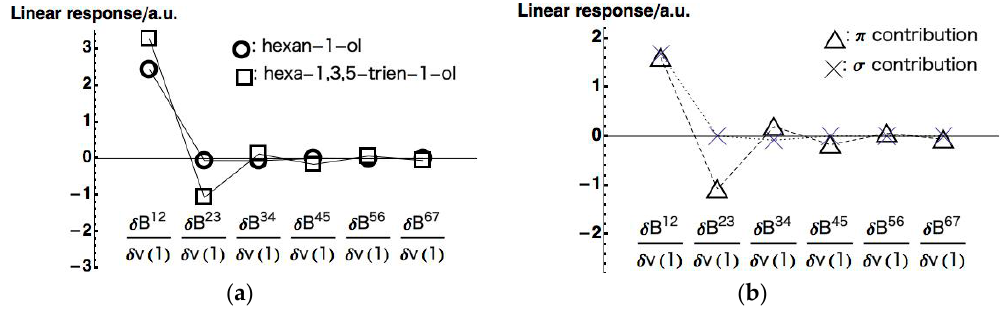
Figure 7. ( a ) LRF-BOs of hexan-1-ol and hexa-1,3,5-trien-1-ol molecules; ( b ) σ and π contributions of LRF-BO of the hexa-1,3,5-trien-1-ol molecules.